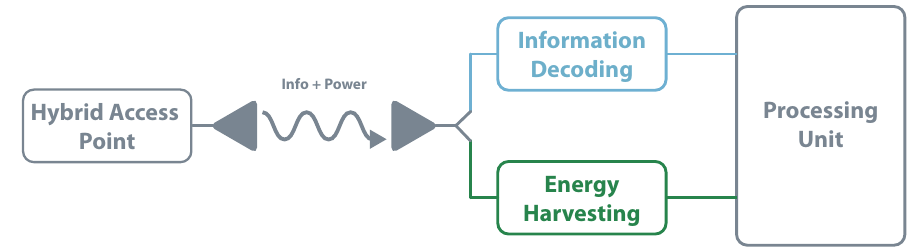
Figure 15. SWIPT—power splitting architecture.